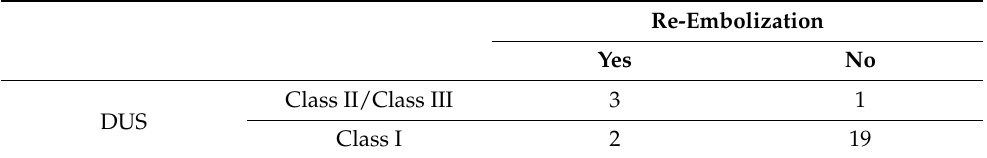
Table 4. DUS’s ability to diagnose the need for